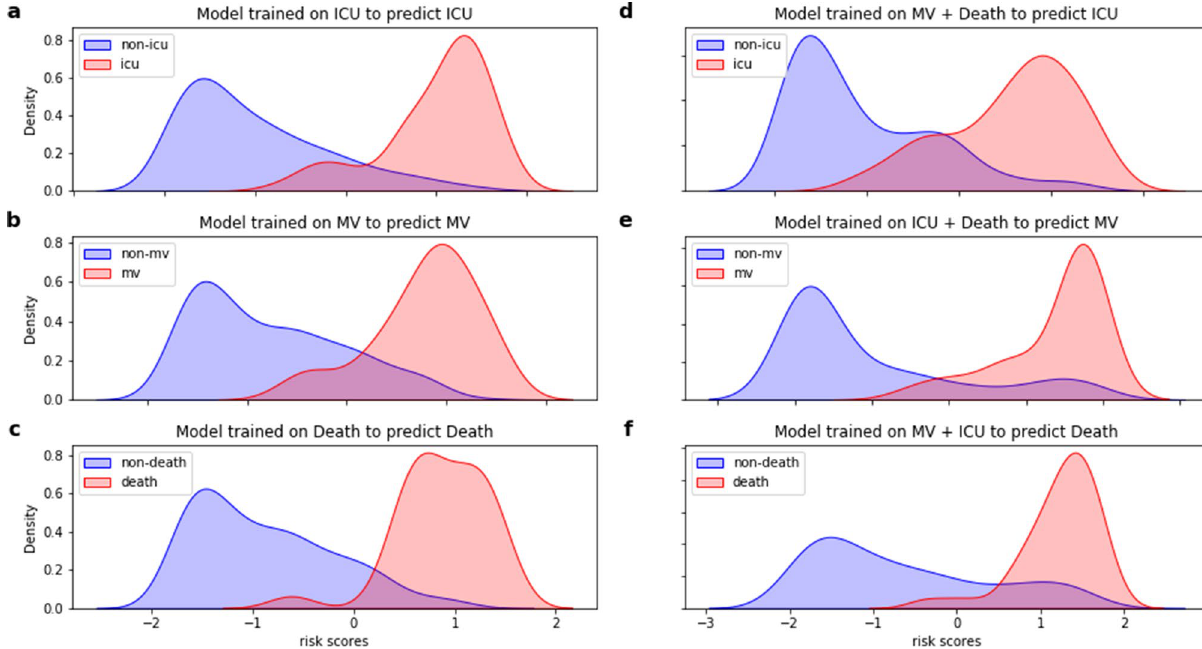
Figure 1. Density plots for the three severe COVID-19 outcomes, BP Hospital—A Beneficência Portuguesa de São Paulo, Brazil, 2020. ( a – c ) Density plots for the single outcome models. ( d – f ) Density plots for the aggregated models predicting unspecific